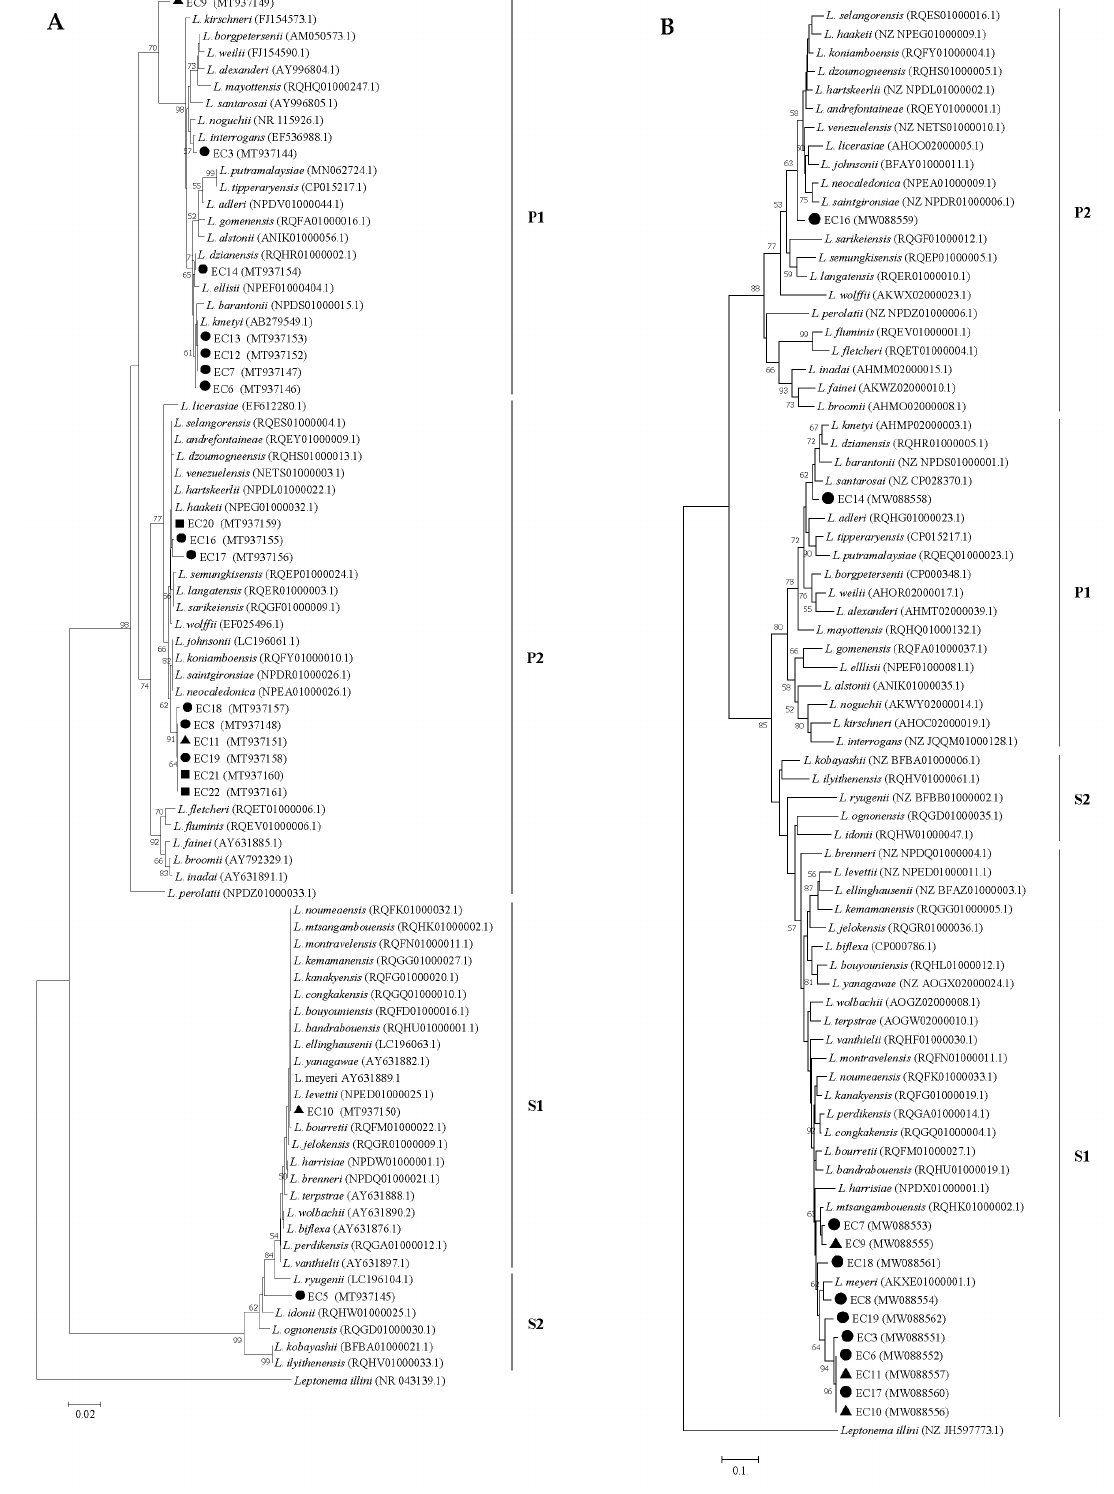
Figure 2. Neighbor-joining phylogenetic tree of partial 16S rRNA ( A ) and secY ( B ) sequences of Leptospira isolated from the environmental samples of the elephant camp areas. Circle, triangle, and square indicated the environmental isolates from a river, a mud pond, and water supplies, respectively. A bootstrap of 1000 replicates was performed and values above 50% are shown in the nodes. Leptonema illini was used as the outgroup. The GenBank accession numbers of our isolates and reference species are shown in the